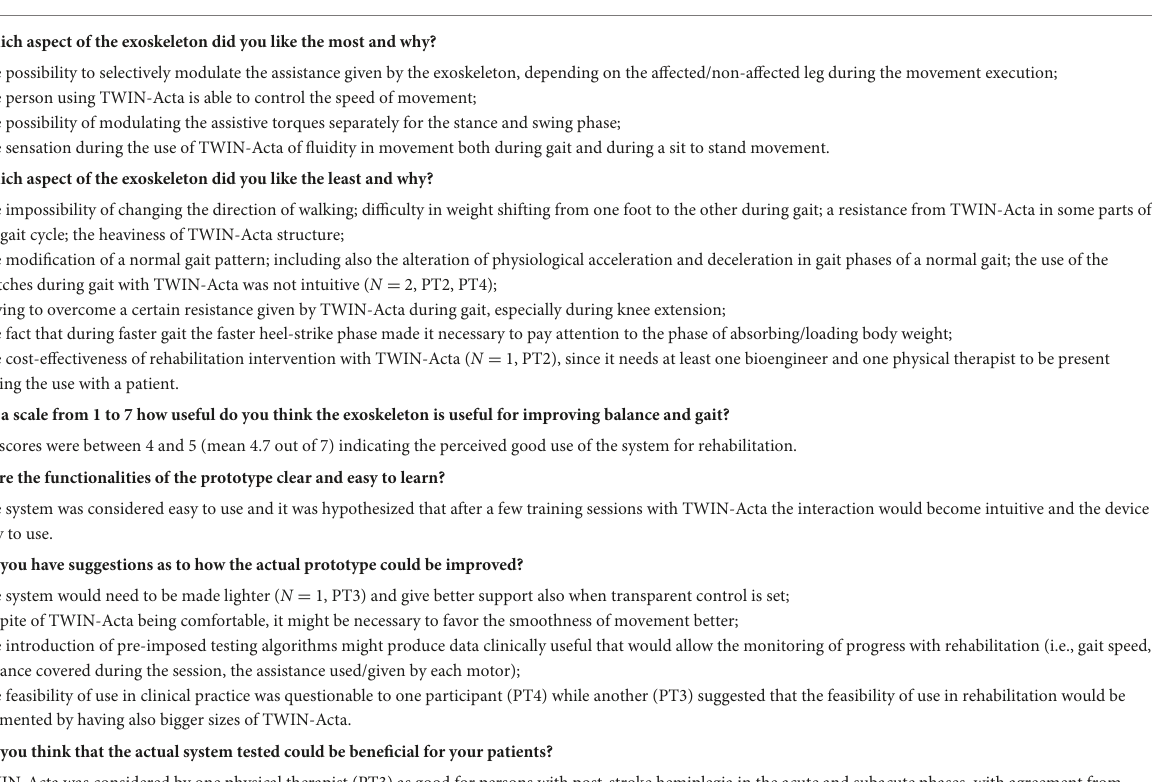
TABLE 5 Semi-structured questionnaire responses (items 4–11) provided at T2 by the three physical therapists, the expert neurologist, and the bioengineer.